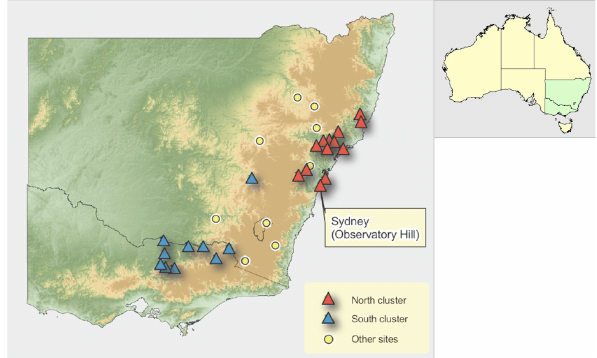
Fig. 1. Location of 31 sites with at least 25yr of data for the period 1976 to 2005. For Sydney Observatory Hill the period 1921 to 2005 was analysed. (Symbols indicate cluster membership discussed in Sect.